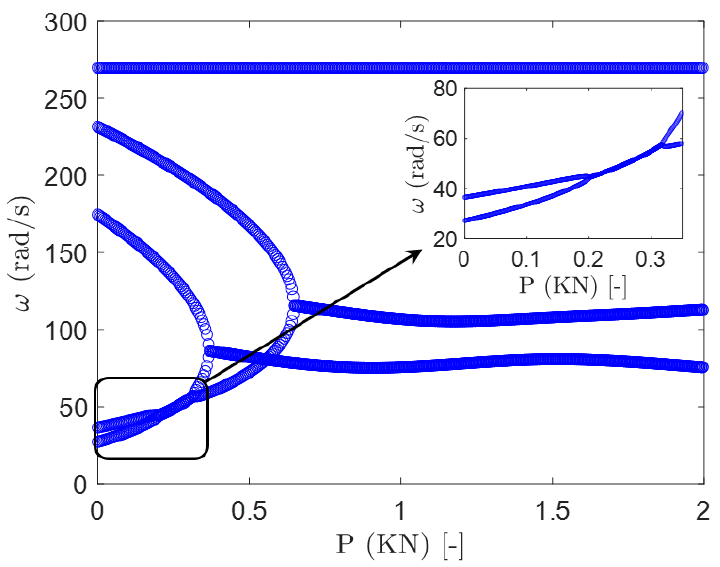
Figure 7. The effect of compressive force on the stationary frequencies of the composite blade with antisymmetric layup and for 𝜃 = 20 o and Ω b = 0 .